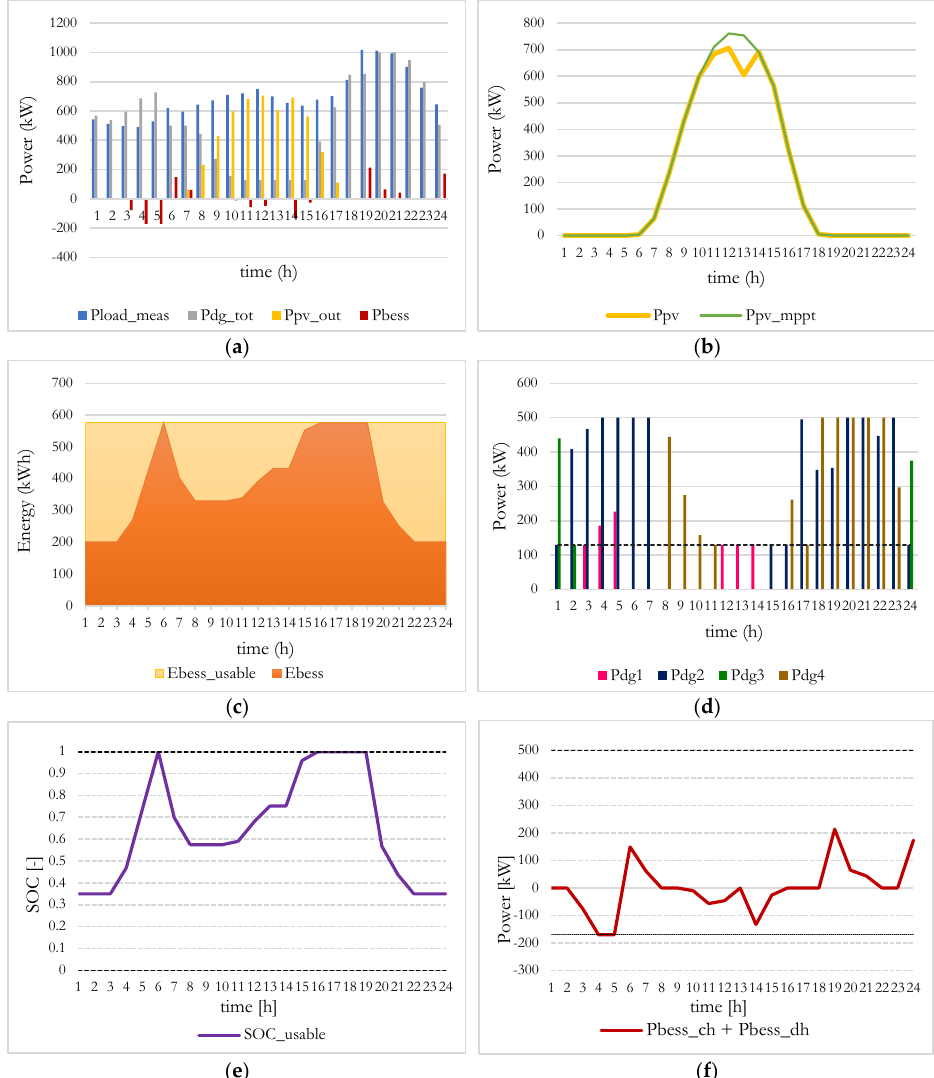
Figure 5. Results of the MIP optimization model. ( a ) Main power flows; ( b ) Comparison between MPPT PV power and PV power of MIP; ( c ) BESS energy compared to the usable quantity; ( d ) DG power; ( e ) Usable SOC; ( f ) BESS power profile.